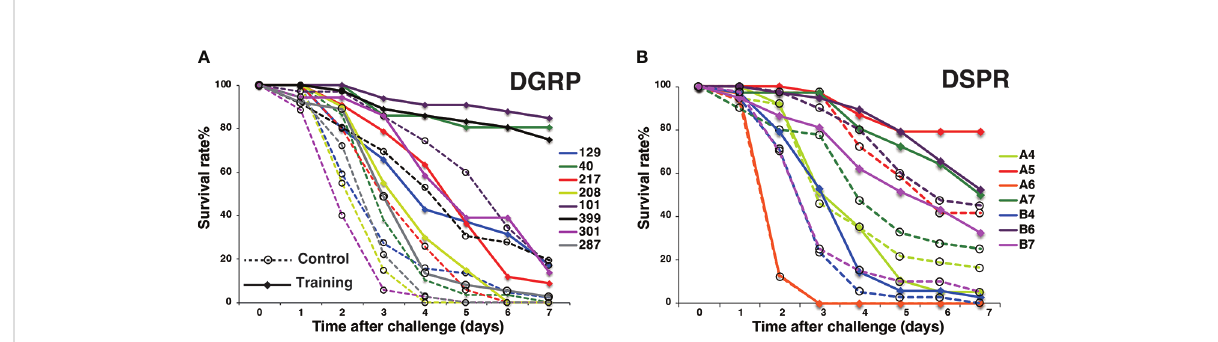
FIGURE 2 Pilot experiments using the DGRP and DSPR population libraries. (A) Survival curves of the eight DGRP lines. DGRP line numbers were shown in the graph. Statistically signi fi cant differences between control and training conditions were detected in all lines using the log-rank test. (B) Survival curves of seven DSPR founder lines (#A4, #A5, #A6, #A7, #B4, #B6, and #B7). Statistically signi fi cant differences between control and training conditions were detected except in lines #A4, #A6, and #B6. Survival curves were measured in two or three independent experiments. Survival rates under control and training conditions are marked by dashed lines and full lines,